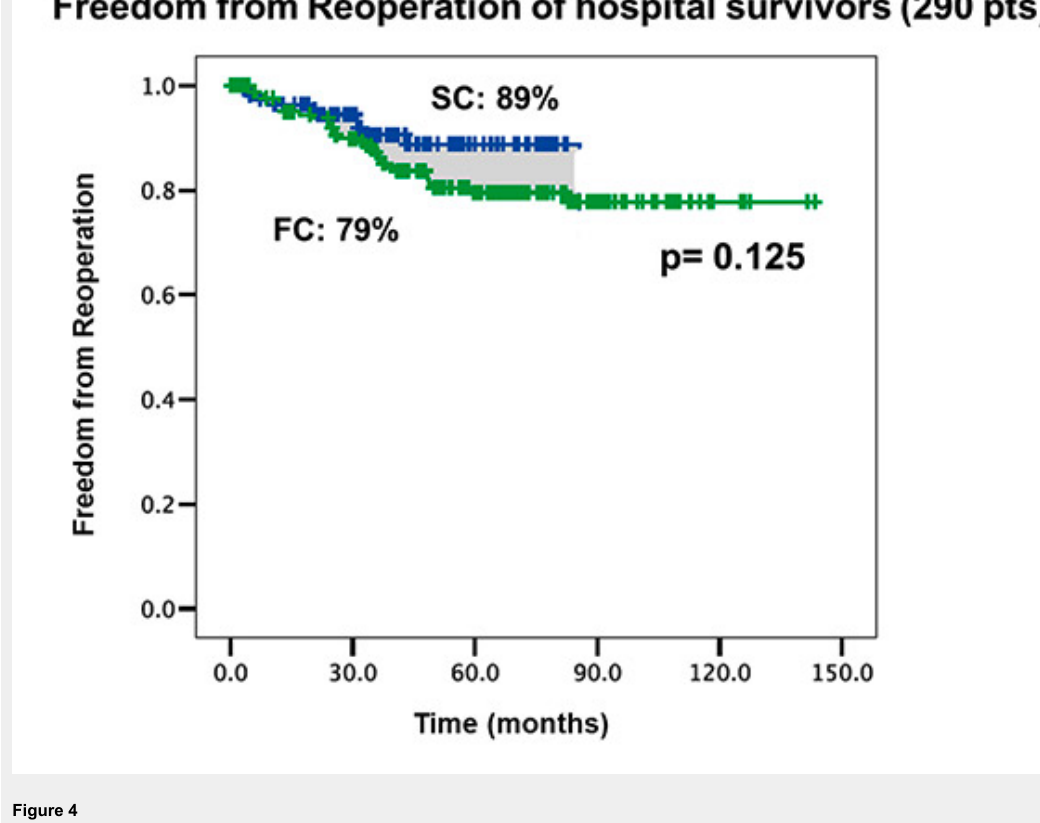
Figure 4 Freedom from re-operation at follow-up (290 patients); SC: blue; FC: